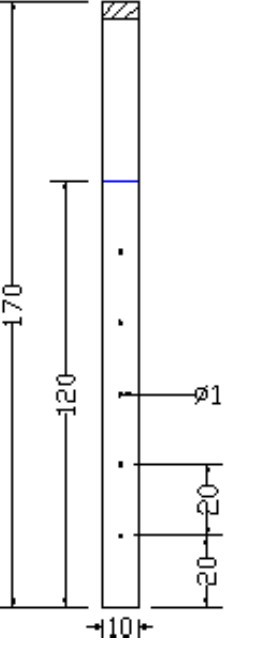
Figure 5. Grouting probe. Table 5. Mixing proportions for 1 cubic meter of the grout material.